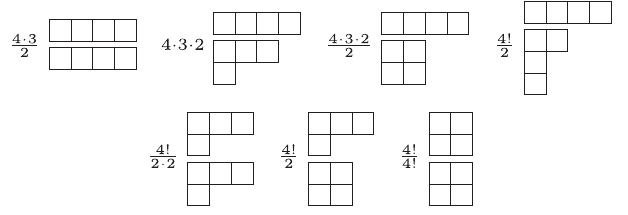
FIG. 4. Use of Young diagrams for computing ξ 0 . In the example, N ¼ 8 and d ¼ 4 . The fraction before each pair gives the number of different fillings and hints at how it is